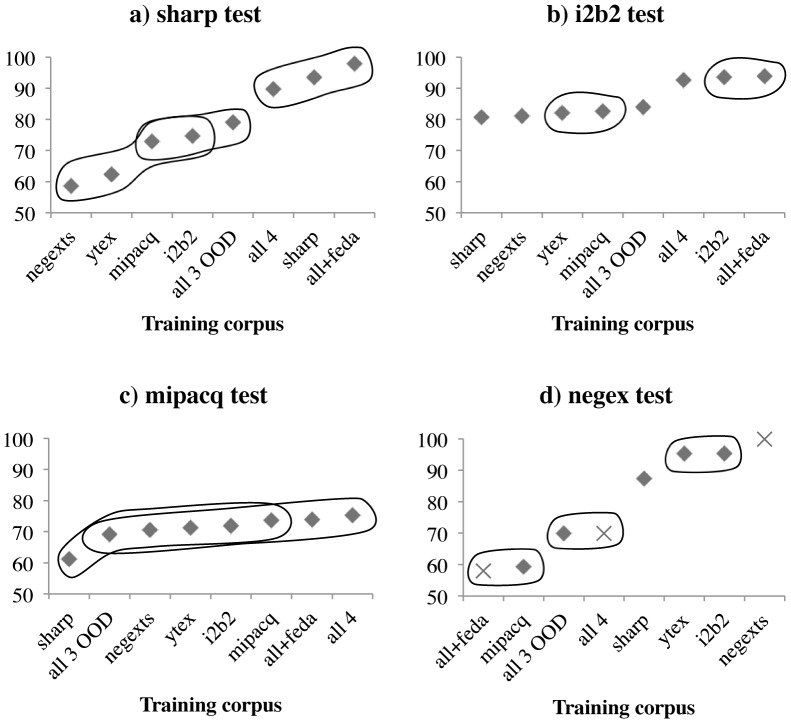
Significance bands of model performance for each test corpus.These are labeled with successive letters from right to left in Table 4.